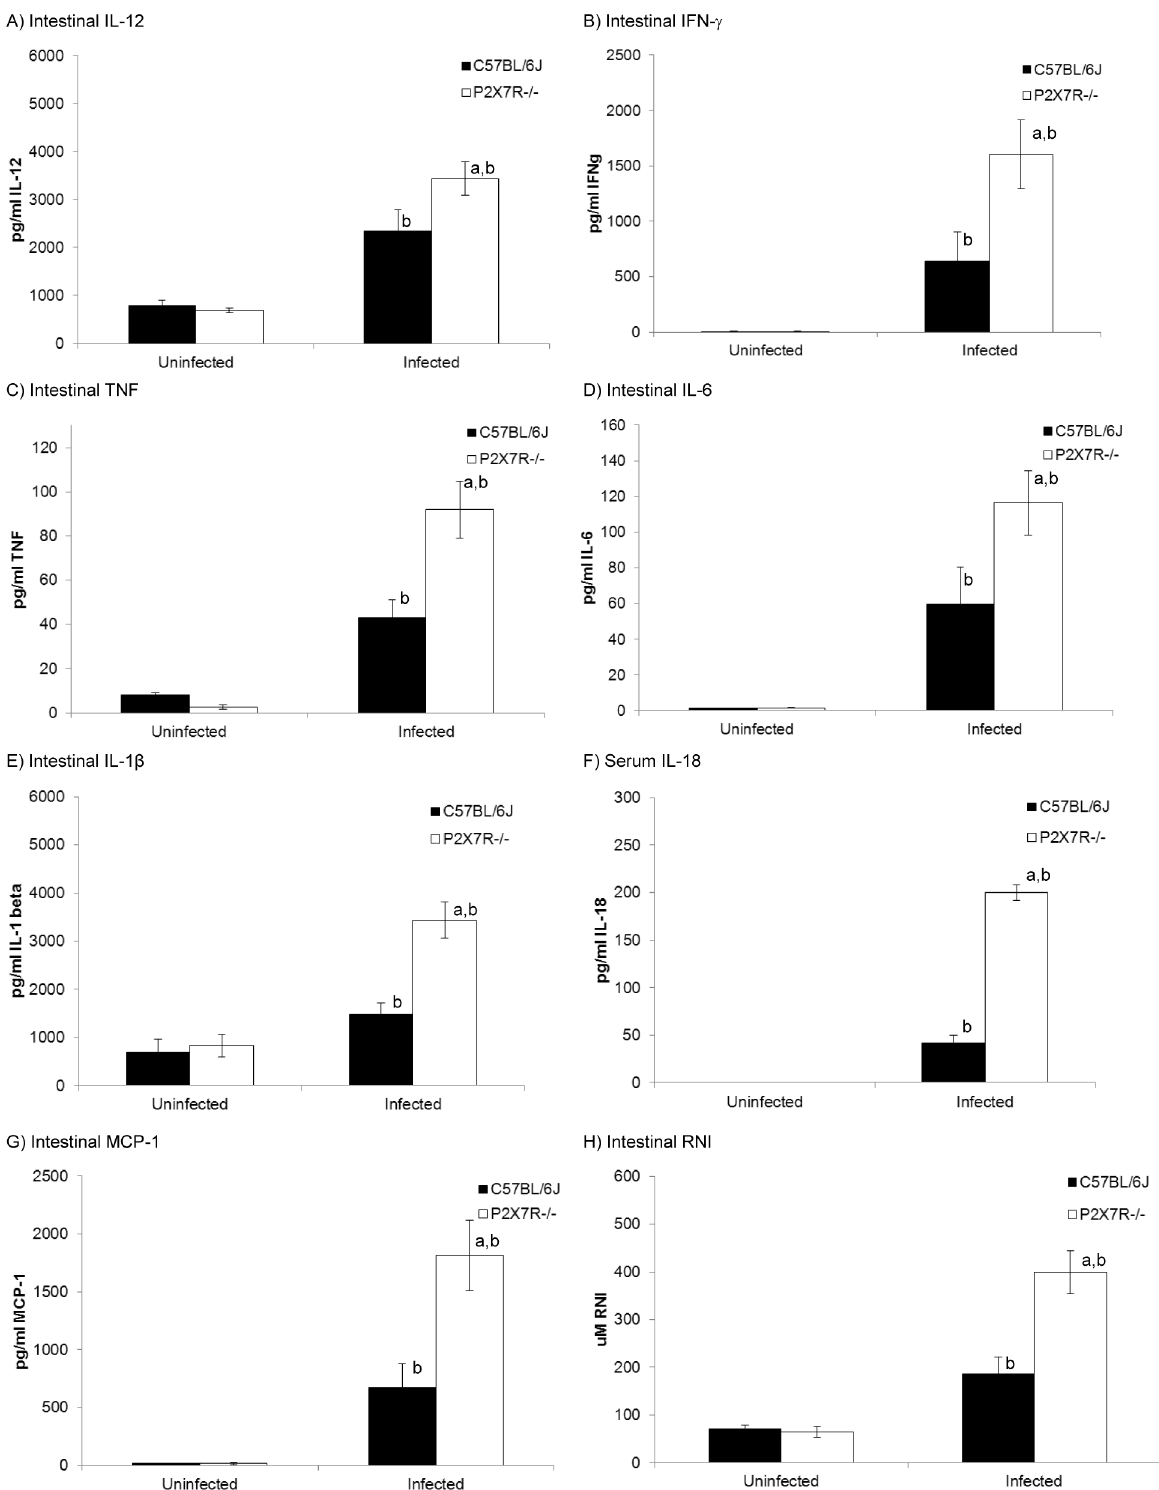
Fig 3. Inflammatory cytokine production is dysregulated in P2X7R -/- mice compared with wild type in association with toxoplasmic ileitis. Male mice (6 – 8 weeks old) were infected orally with 10 T . gondii Me49 cysts and euthanased 8 days post-infection. Ileal homogenates were collected for quantification of cytokine levels by ELISA (IL-1 β , IL-6, IL-12, TNF, MCP-1, IFN- γ ) or Griess assay (reactive nitrogen intermediates) as described in the Materials and Methods. Sera was analyzed for IL-18. Following infection, P2X7R -/- mice (n = 10) exhibited significantly higher levels of (A) IL-12, (B) IFN- γ ,